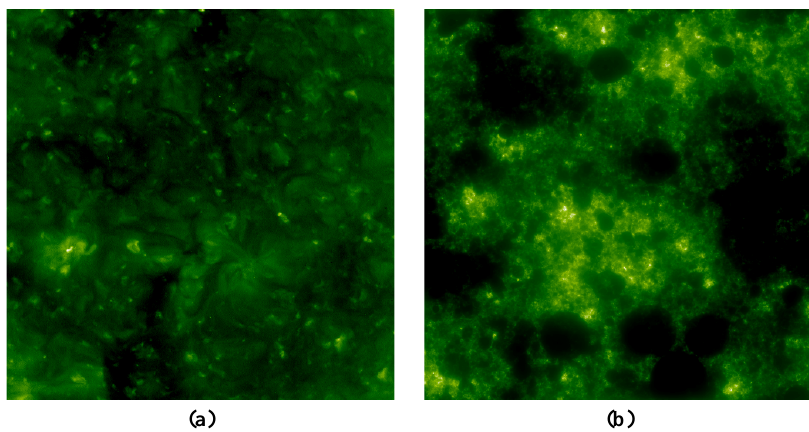
Fig. 5. Examples of 512 × 512 images of (a) Quiet Sun, (b) a fractionally integrated compound Poisson cascade.